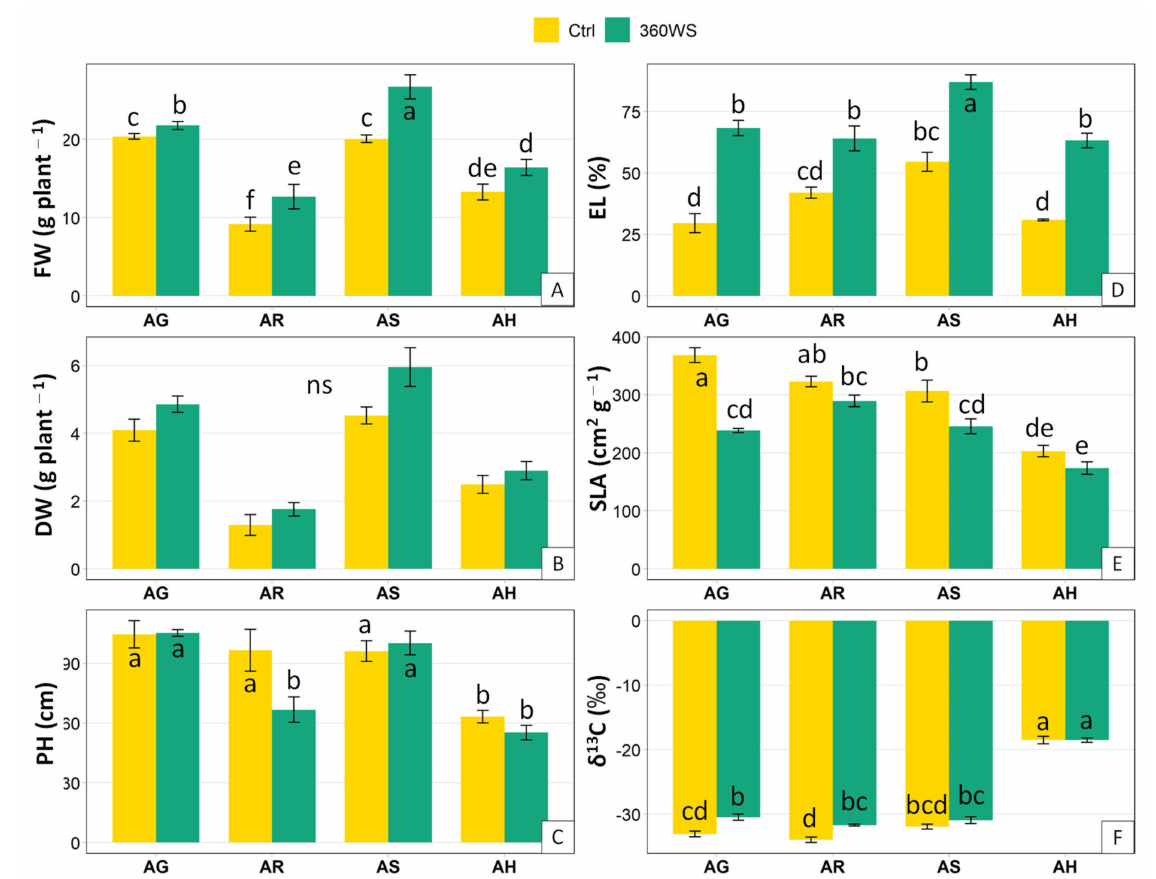
Figure 1. ( A ) Fresh weight, ( B ) dry weight, ( C ) plant height, ( D ) electrolyte leakage, ( E ) specific leaf area, and ( F ) 13 C isotope ratio under control (Ctrl) and 360 mM water salinity (360 WS) in the four genotypes A. hortensis cv. green (AG), A. hortensis cv. red (AR), A. hortensis cv. scarlet (AS), and A. halimus (AH). Vertical bars indicate standard error ( n = 4). Different letters indicate significant differences at p <